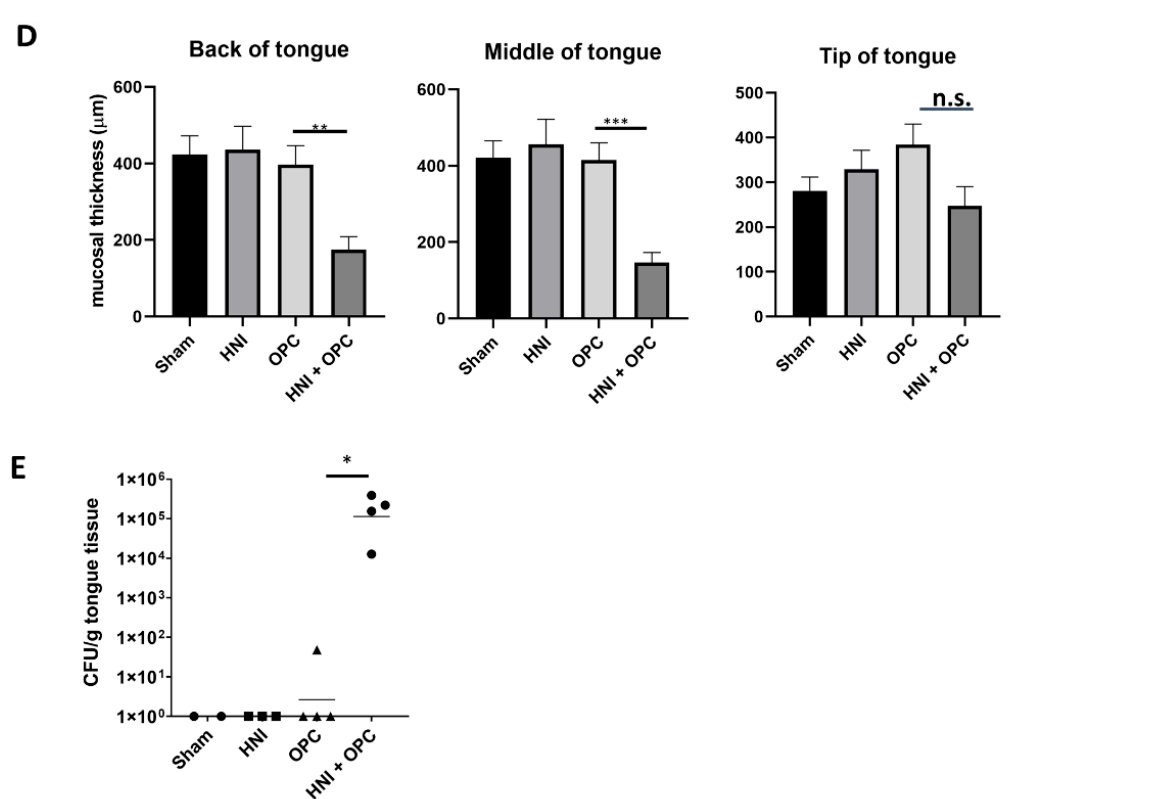
Figure 1. HNI increases susceptibility to OPC. ( A ) Timeline of HNI and OPC exposure. Mice were exposed to HNI on day -1 and OPC on day 0, 12–15 h after HNI exposure. WT mice received no radiation and no OPC (sham), HNI alone (HNI), OPC alone (OPC), or both (HNI + OPC). Tongues were harvested on Day 4. ( B ) HNI + OPC mice (n = 9) lost significantly more body weight (BW) compared to Sham (n = 4), HNI-only (n = 7), OPC-only (n = 7) groups. All mice were weighed daily, and % body weight loss (grams) on each day of infection determined. Analyzed by one-way ANOVA with Tukey’s post hoc. ( C ) The portions of the tongue with visual lesions were quantified by determining the surface area of the tongue positive for staining with toluidine blue compared to the total surface area of tongue on each mouse on Day 4 post infection using ImageJ software. ( D ) Quantification of mucosal thickness on the tip, middle, and back of tongue. Measured from basal stem cell layer up to papillae using ImageJ software. Three mice were analyzed from each group, with three sections per mouse. Investigators analyzing toluidine blue staining and measurement of mucosal thickness were blinded to treatment and mouse cohort. Analyzed by one-way ANOVA with Tukey’s post hoc. ( E ) WT mice were subjected to HNI + OPC and on Day 4 tongue tissue was harvested, tissue homogenized and plated then CFU/g of tongue tissue was determined in triplicate. Analyzed by Mann-Whitney U test. Data shown as geometric mean. (* p < 0.05, ** p < 0.01, *** p < 0.001, **** p < 0.0001). n.s. is not significant. Data represent 3 experimental